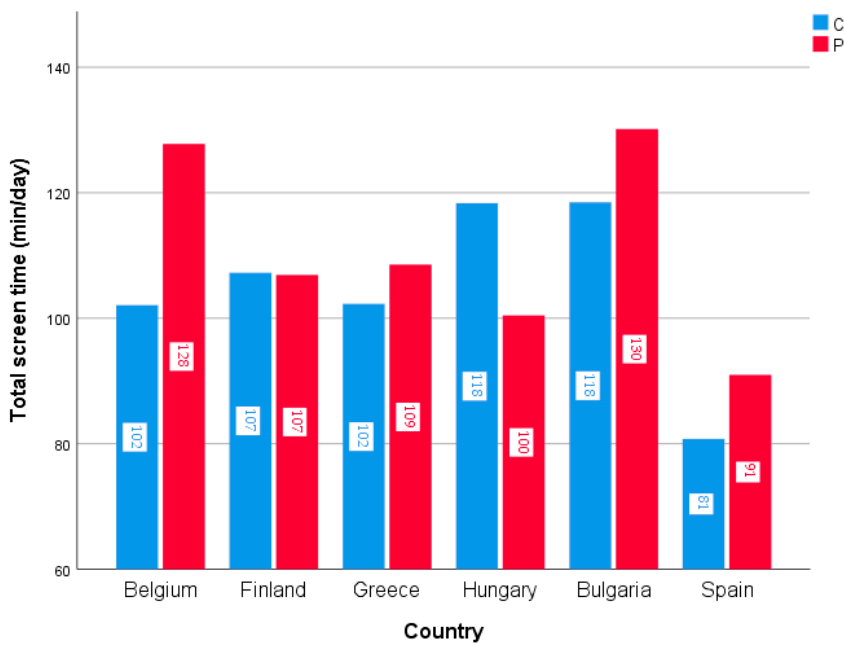
Figure 3. Average amount of children’s (in blue) and parents’ (in red) total screen time for each of the six European countries.